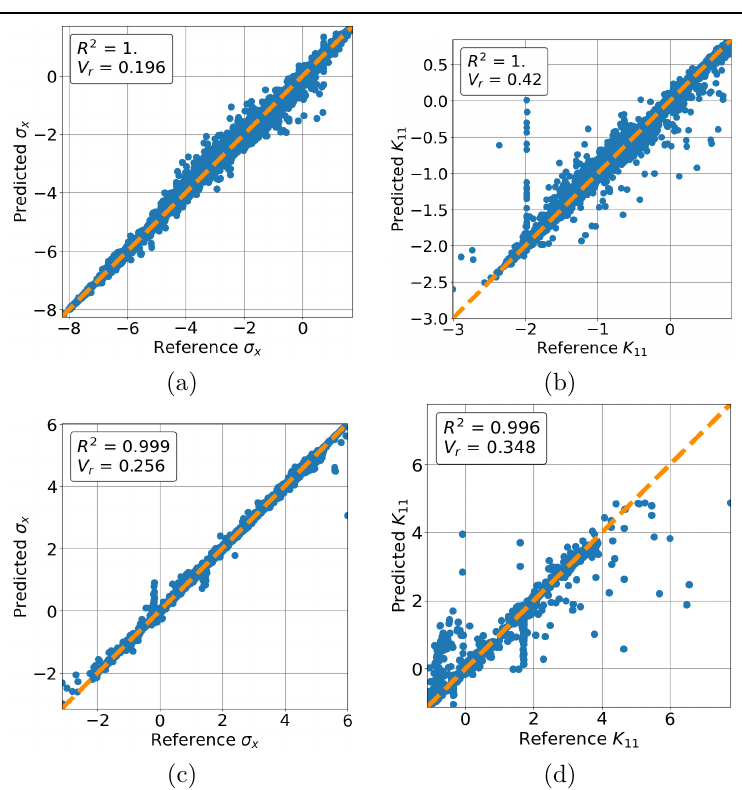
Figure 4. kNN results for: (a) stress component σ component σ in CF 1, and (d) stiffness component K x